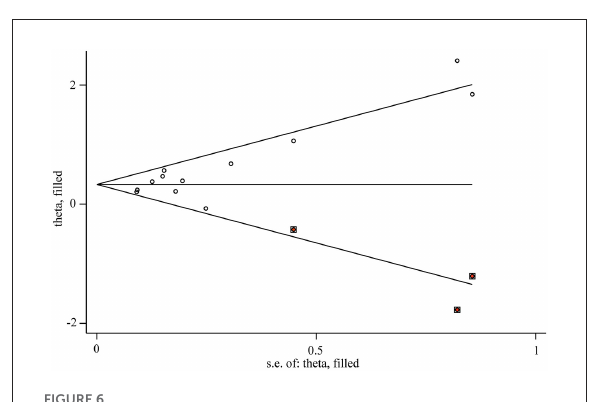
FIGURE6 Funnel plot of included studies (after trim and